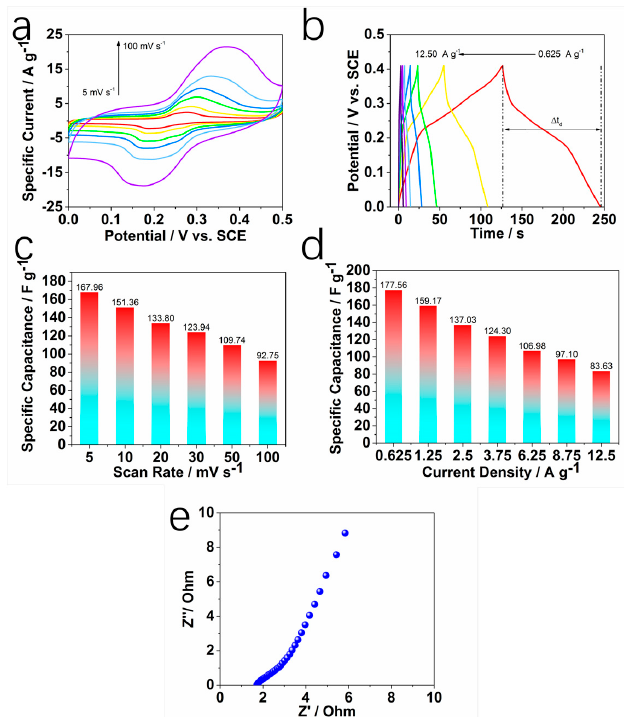
Figure 7. ( a ) CV curves of the sample without GO material in the three-electrode system; ( b ) GCD curves of the sample without GO at various current densities; ( c ) specific capacitances derived from the CV curves; ( d ) specific capacitances calculated from the GCD curves; ( e ) EIS (electrochemical impedance spectroscopy) for MnPO 4 · H 2 O nanowire without GO electrode.